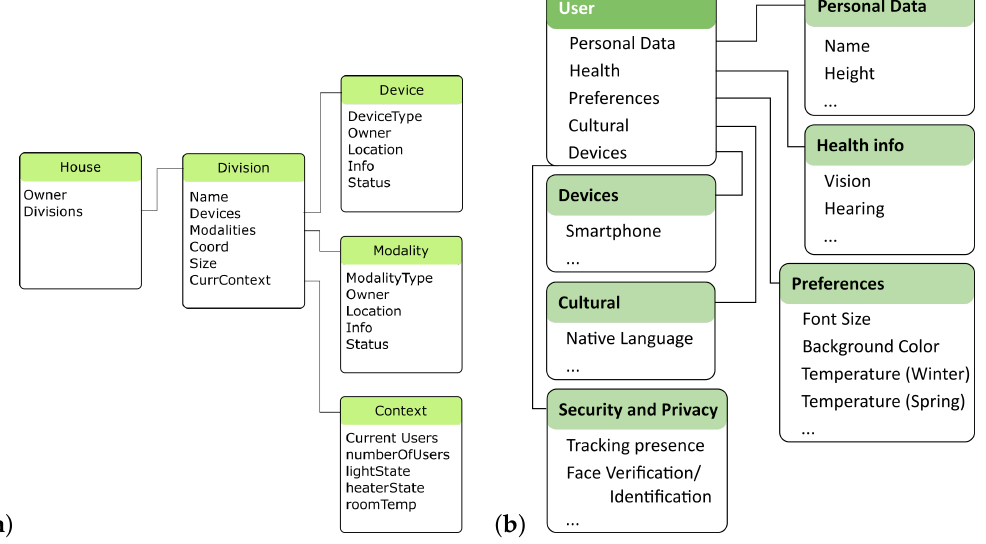
Figure 8. The framework Integrates, at this stage, ( a ) simple context and ( b ) user